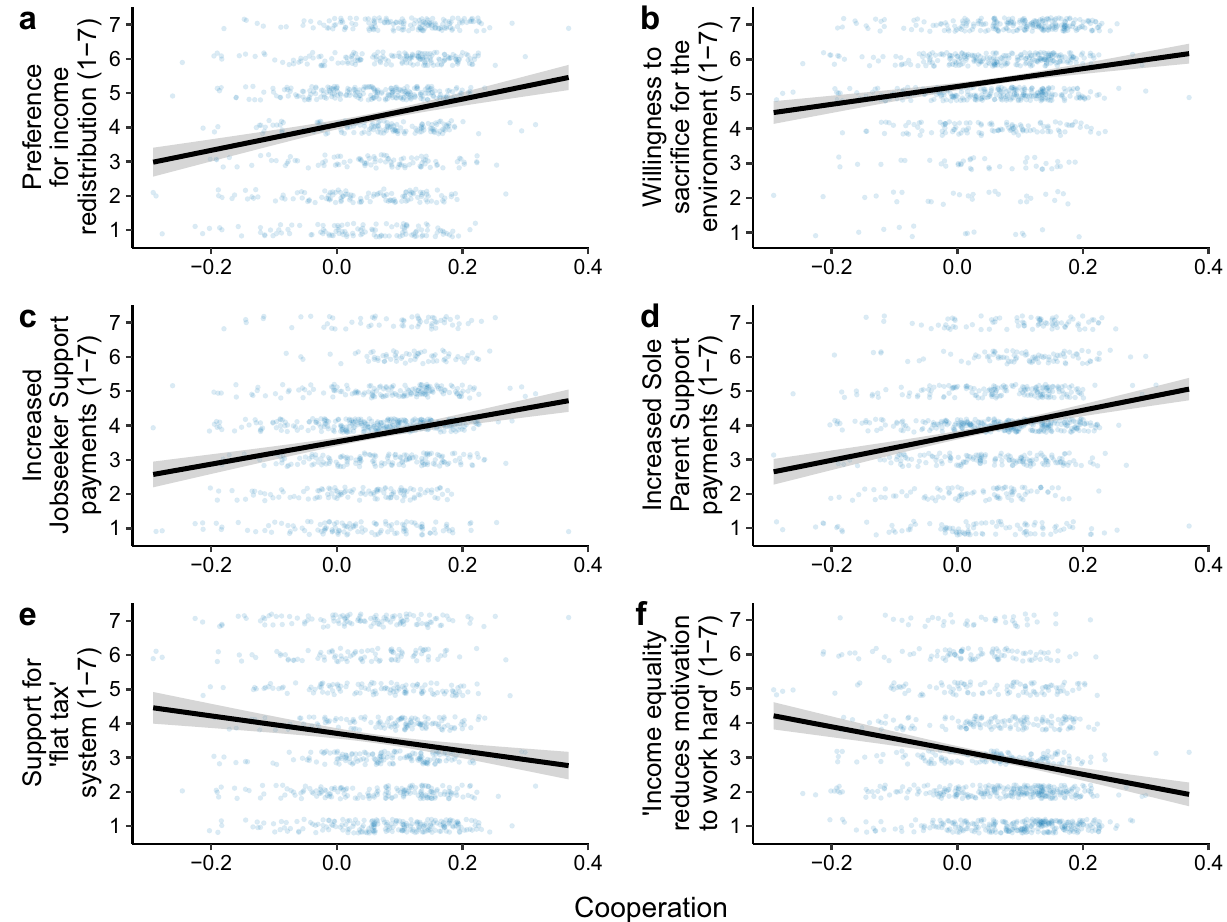
Figure 3. The cooperation latent variable predicts a host of economically progressive views. For every Likert scale, 7 indicates increased support for the policy or agreement with the statement, whereas 1 indicates reduced support for the policy or disagreement with the statement. For visualisation ease, regression lines and 95% confidence interval shaded areas are predictions from least-squares linear regressions without demographic covariates. Note that the latent variable scores are not raw data, but rather model predictions that are estimated with error that is not visualised in the